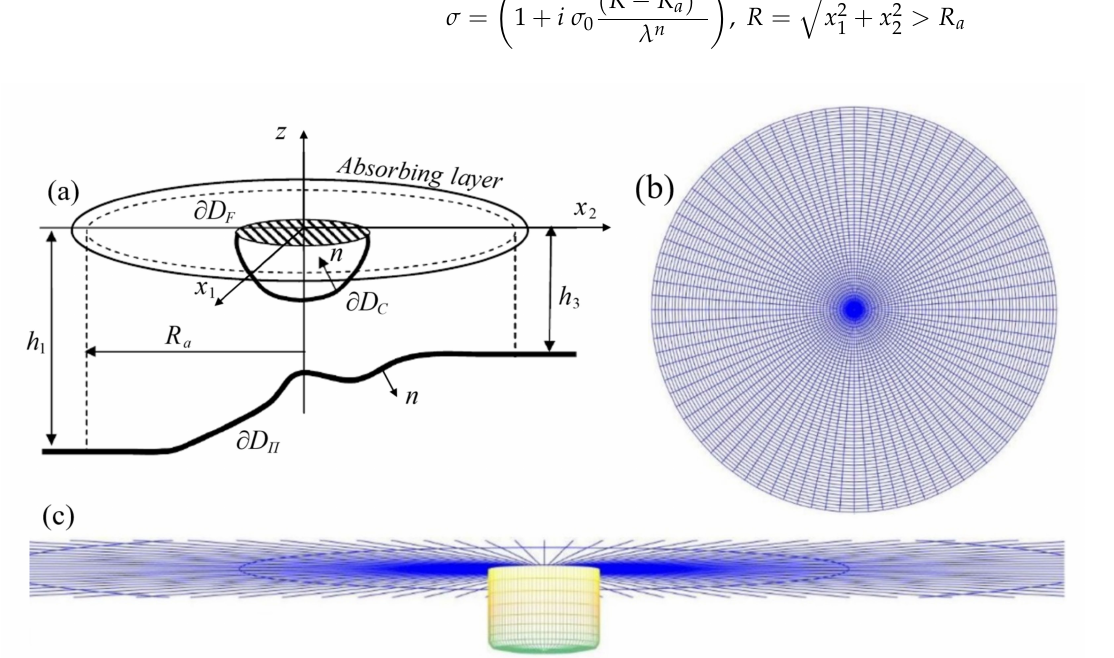
Figure 6. ( a ) Formulation of diffraction and radiation problems in variable bathymetry regions, and computational meshes: ( b ) Free Surface mesh, ( c ) 3D side view of the mesh near the floating